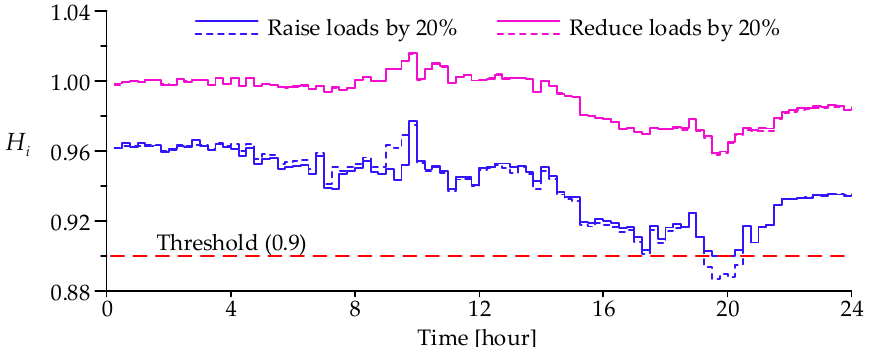
Figure 9. The values of voltage stability index H i at bus 17 for the two cases with different levels. load